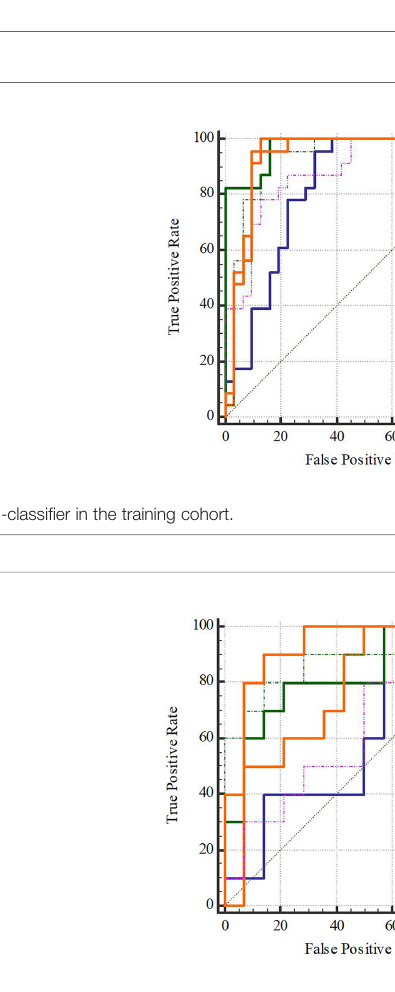
FIGURE 7 | SVM-classi fi er in the validation cohort. Figures 4 – 7 The ROC curve of different models and classi fi er in the training and validation cohorts. TABLE 11 | Delong Test between each two models of SVM-classi fi er in the training and validation cohorts. Radiomic model